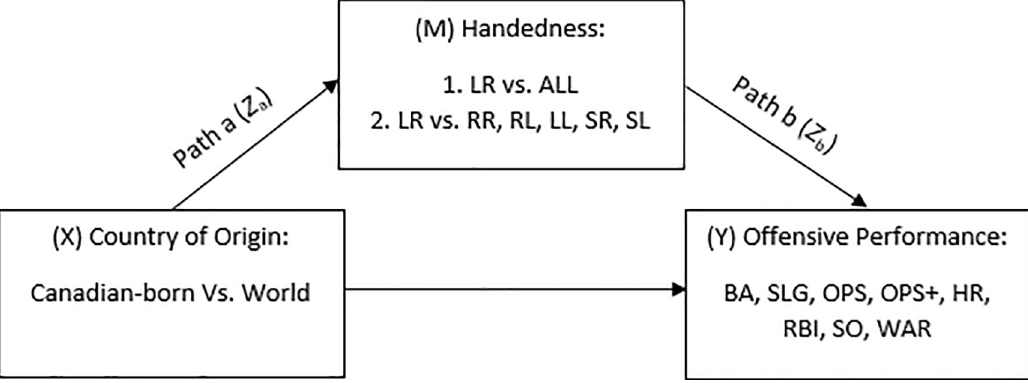
Fig 1. Proposed Mediational Pathway by which Country of Origin Influences Offensive Performance through Handedness in Batting and Throwing. LR = throws left, bats right; LL = throws and bats left; RR = throws and bats right; RL = throws right, bats left; SR = bats left and right, throws right; SL = bats left and right, throws left; BA = batting average; SLG = slugging percentage; OPS = on-base plus slugging; OPS+ = on-base plus slugging plus; HR = home runs; RBI = runs batted in; SO = strikeouts; WAR = wins above replacement.